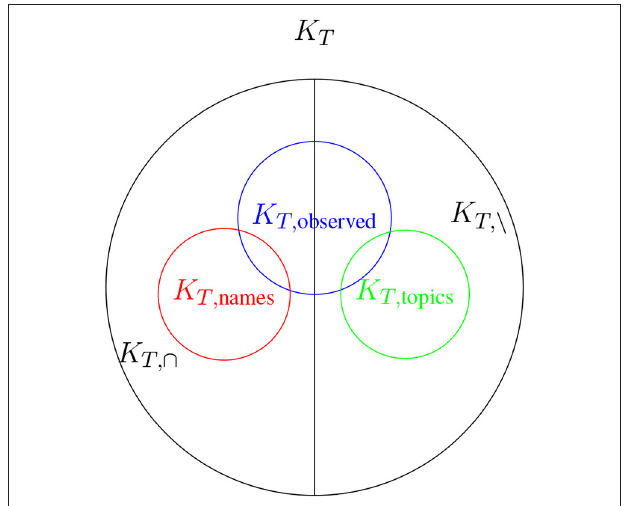
FIGURE 1 | Visualization of all mentioned keyword sets, given that K T ,names ⊂ K T , ∩ and K T ,topics ⊂ K T , \